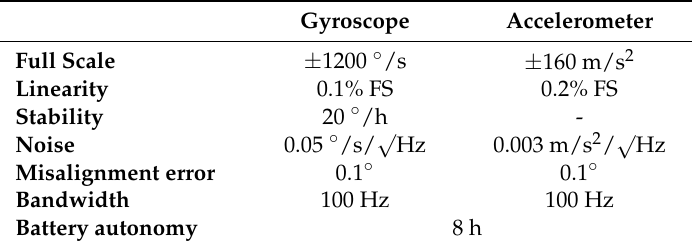
Table 1. Specifics of used the inertial measurement units (IMUs).